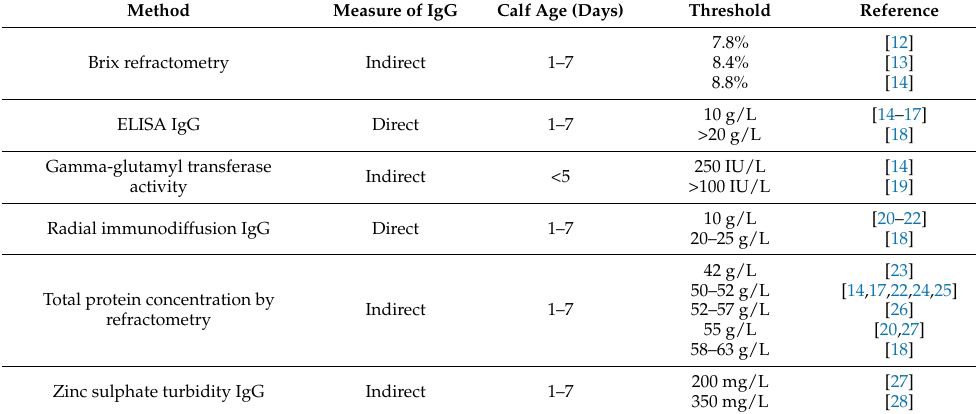
Table 1. Examples of different measures and estimates of transfer of passive immunity in calves from serum samples. Values below the thresholds are indicative of inadequate transfer of passive immunity